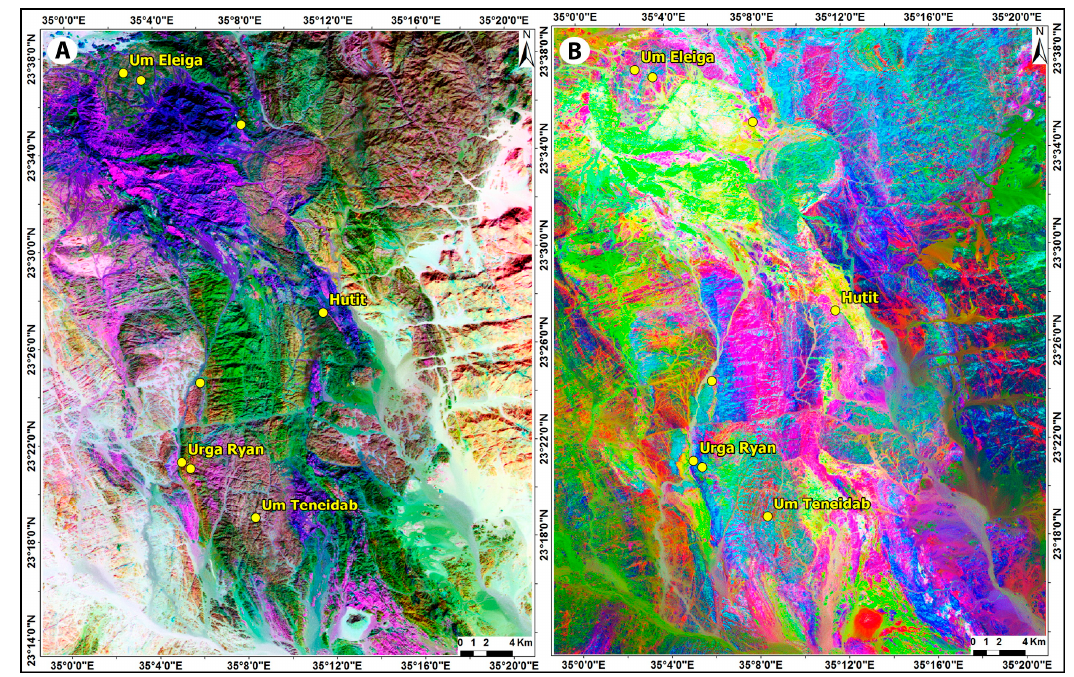
Figure 7. Principal and independent component analysis (PCA and ICA) images of OLI-band ratios, ASTER–RBD, and mineralogical indices. ( A ) FCC principal component (PC) image (R: PC5, G: PC2, B: PC3); ( B ) FCC independent component (IC) image (R: IC3, G: IC1, B: IC2).